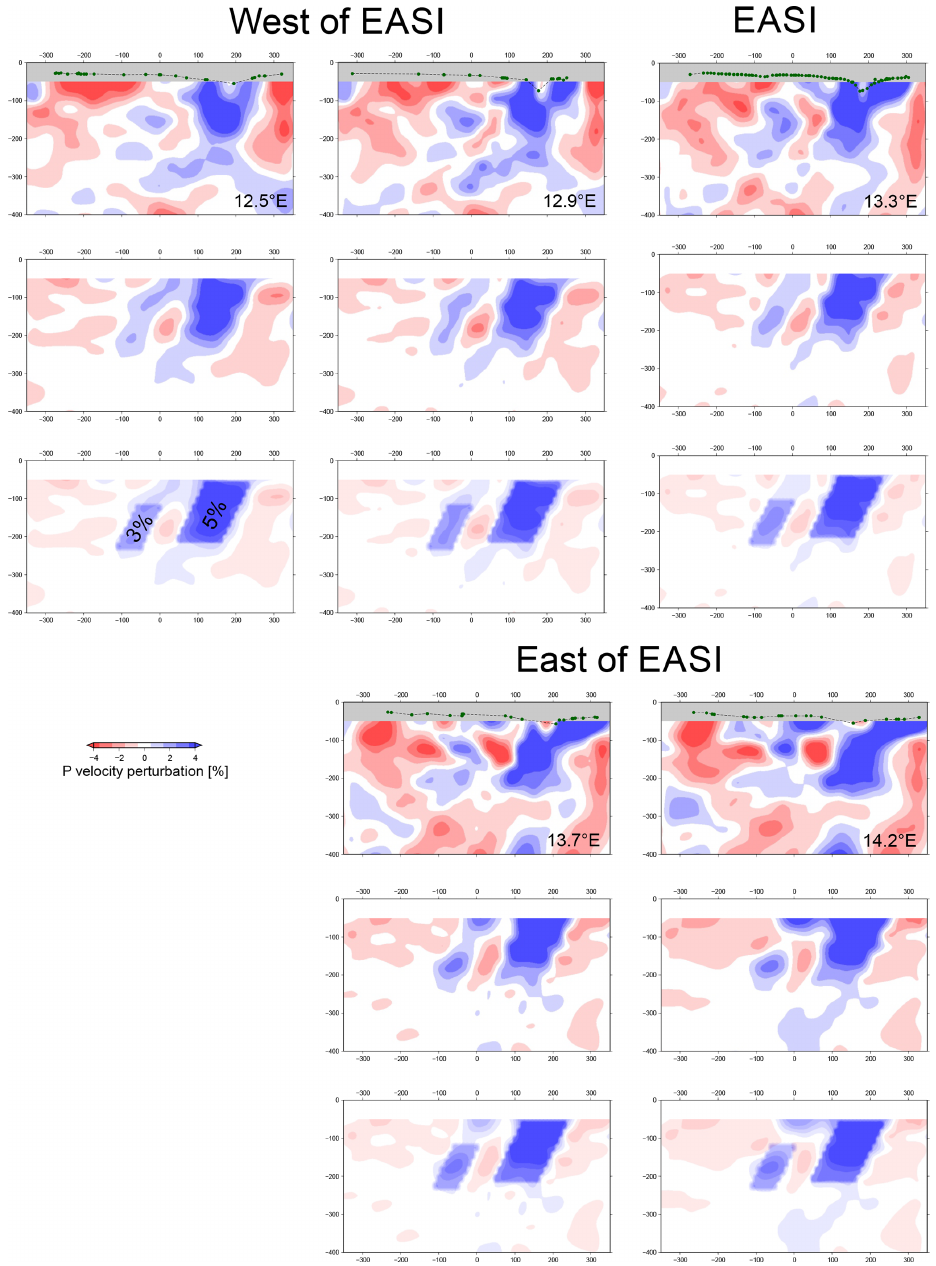
Figure 7. Velocity perturbations along the five vertical along-longitude cross sections calculated from real data (upper row) and those (middle row) calculated from two synthetic 3% and 5% heterogeneities (bottom), plotted over the retrieved perturbations. Green dots mark Moho depths in the model used for calculation of crustal corrections (see also Fig. S3). The along-longitude cross sections run from 51.65 to 45.35 ◦